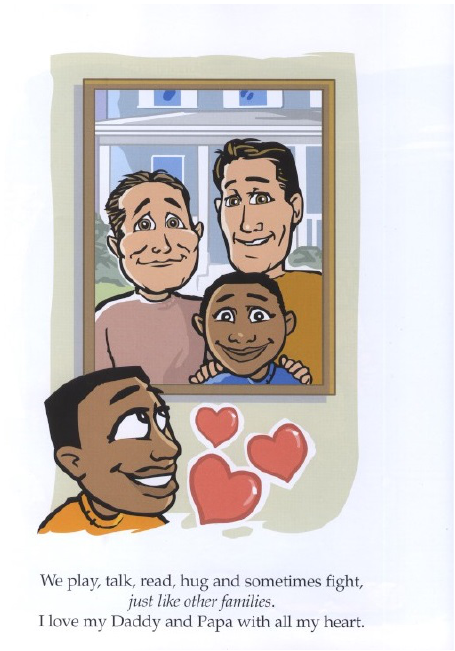
Figure 6. Nehemiah’s autobiographical family tree is rooted in reciprocal affection instead of biological